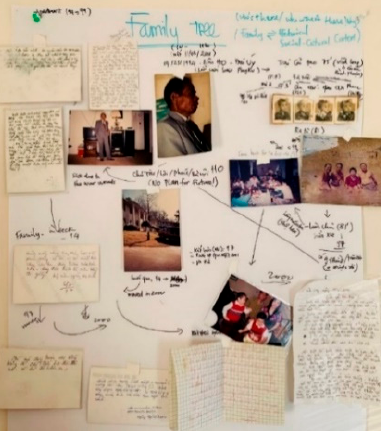
Figure 4. Each description tells a story that takes me and my dad back to the